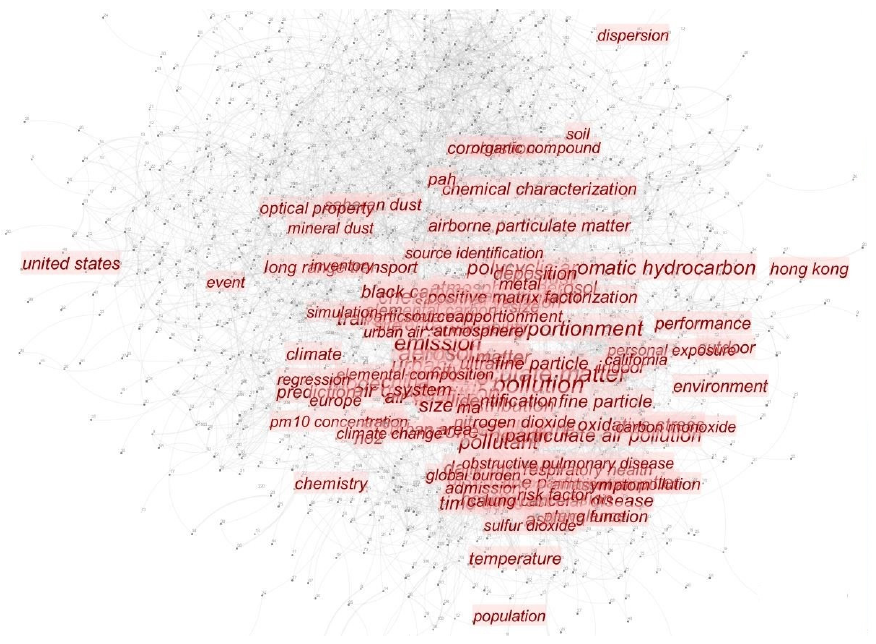
Figure 3. Visualization of editor keywords.